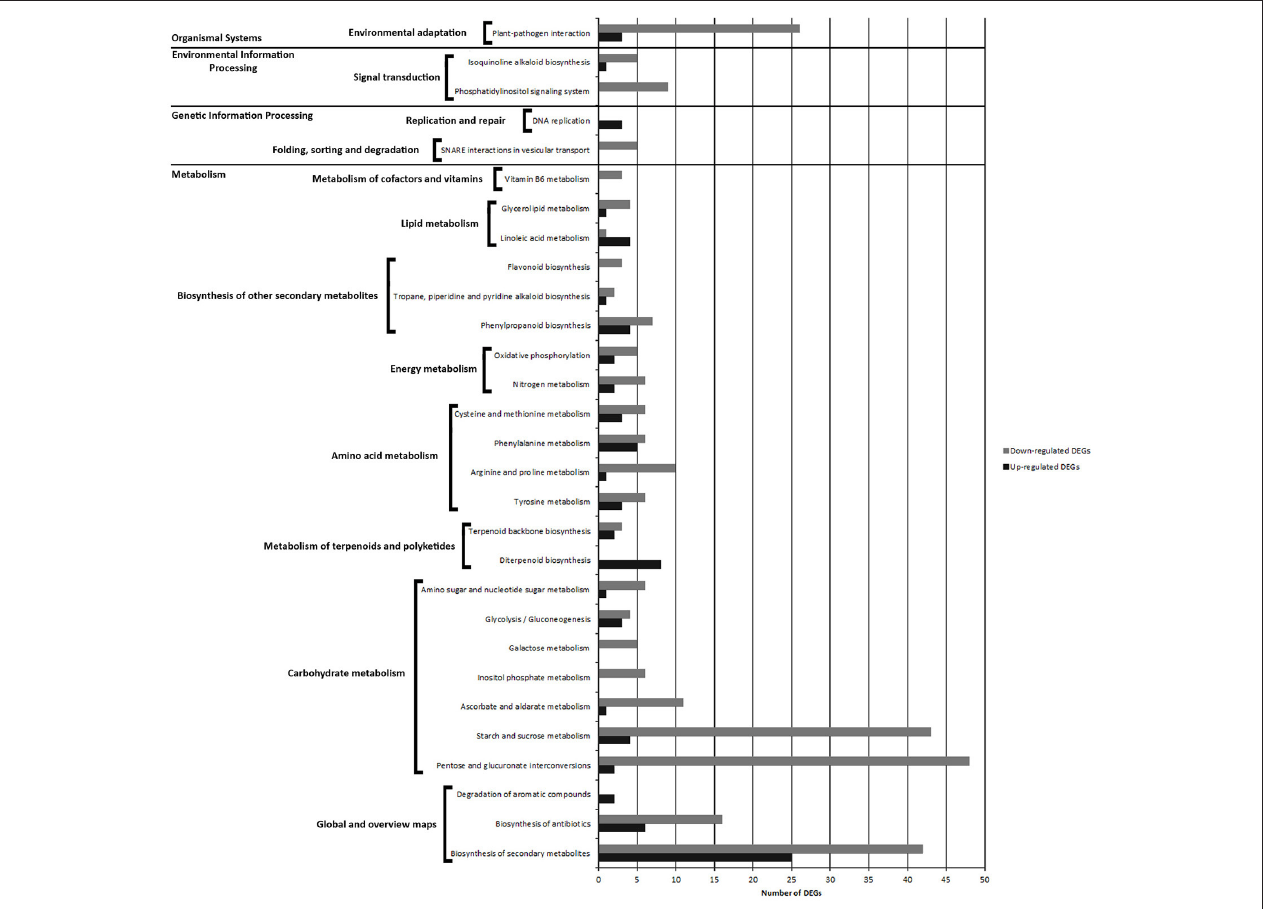
FIGURE 8 | Comparison of the number of up- and down-regulated DEGs identified in PAB vs. PNAB library comparison in the KEGG pathways.